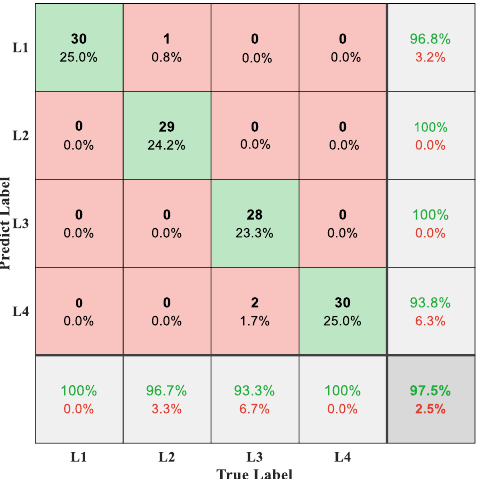
Figure 12. Confusion matrix of different location identification results .